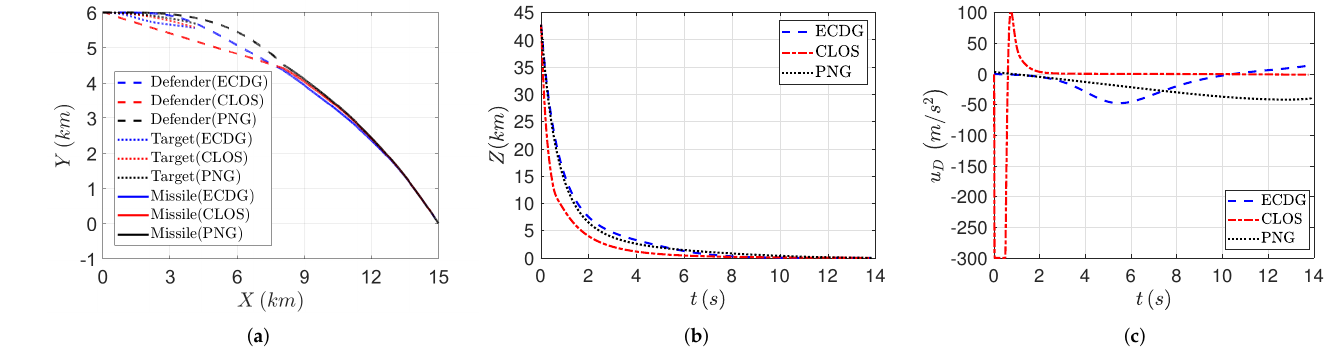
Figure 4. Comparison results of the proposed guidance law with PNG and CLOS. ( a ) Trajectory, ( b ) Zero-effort error distance, ( c ) Guidance command of defender. Table 3. Quantitative Comparison